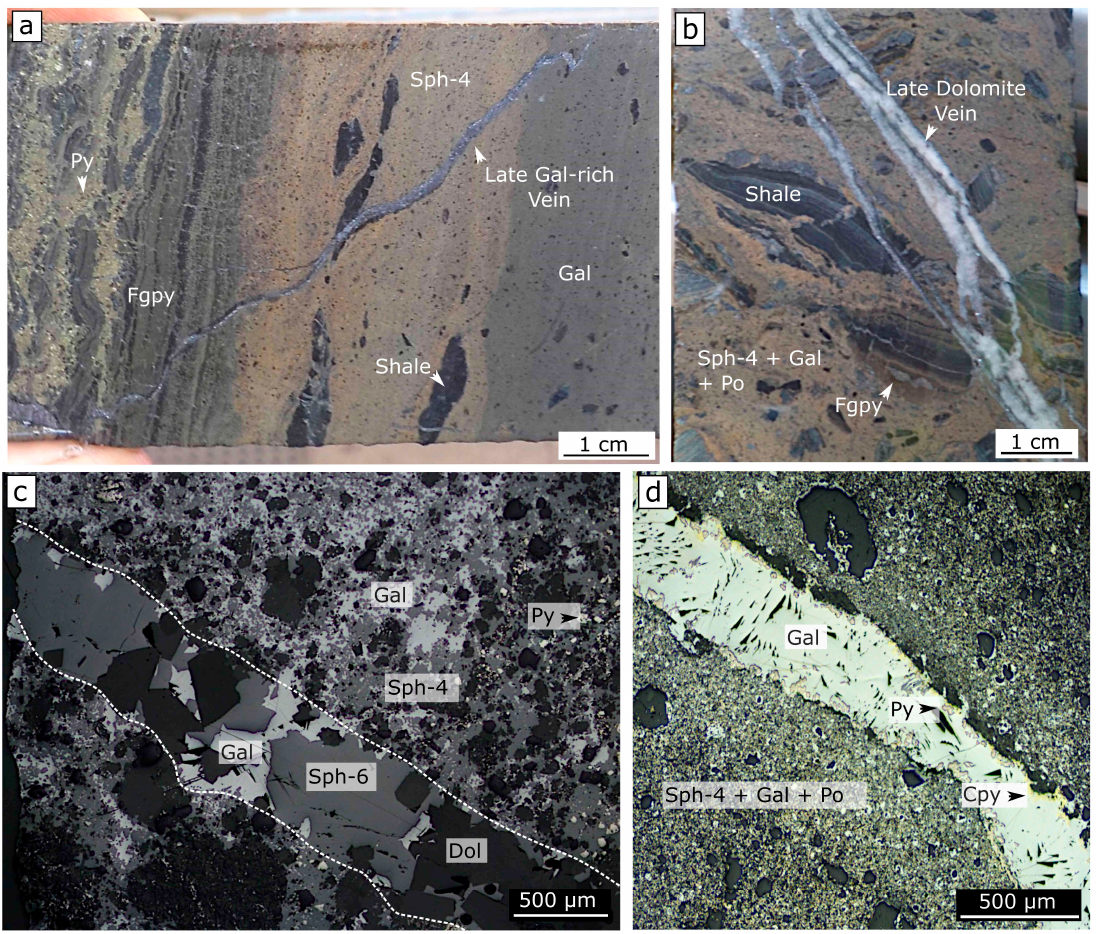
Figure 6. Sphalerite paragenesis at the Hilton Zn-Pb (Ag) deposit (continued). ( a , b ) Polymetallic sulphide-rich breccias cross-cut by late dolomite and sulphide-rich veins containing sph-6 and galena. ( c , d ) Reflected light photomicrographs of late sph-6 bearing veins cross-cutting sph-4 breccia-stage mineralisation. Abbreviations: sph = sphalerite, dol = dolomite, fgpy = fine-grained pyrite, py = pyrite, gal = galena, po = pyrrhotite, cpy = chalcopyrite.